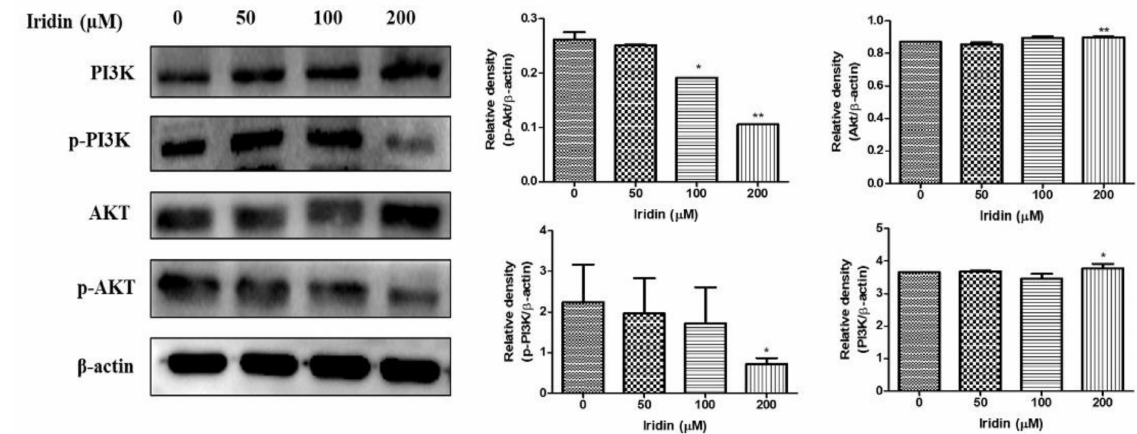
Figure 5. Effect of iridin on inhibition of PI3K/AKT pathway. AGS cells were treated with the indicated concentration of iridin (0, 50, 100, and 200 µ M) for 48 h. The cell lysate was subjected to sodium dodecyl sulfate (SDS)-polyacrylamide gels and transferred onto polyvinylidene difluoride (PVDF) membranes. Following membranes were probed to PI3K, p-PI3K, AKT, p-AKT, and β -actin antibodies. Electrochemiluminescence (ECL) detection system used to visualize the proteins. Bar and error bar values represent the mean ± standard error of the mean (SEM) of three separate datasets. * p < 0.05 vs. control, ** p < 0.01 vs.